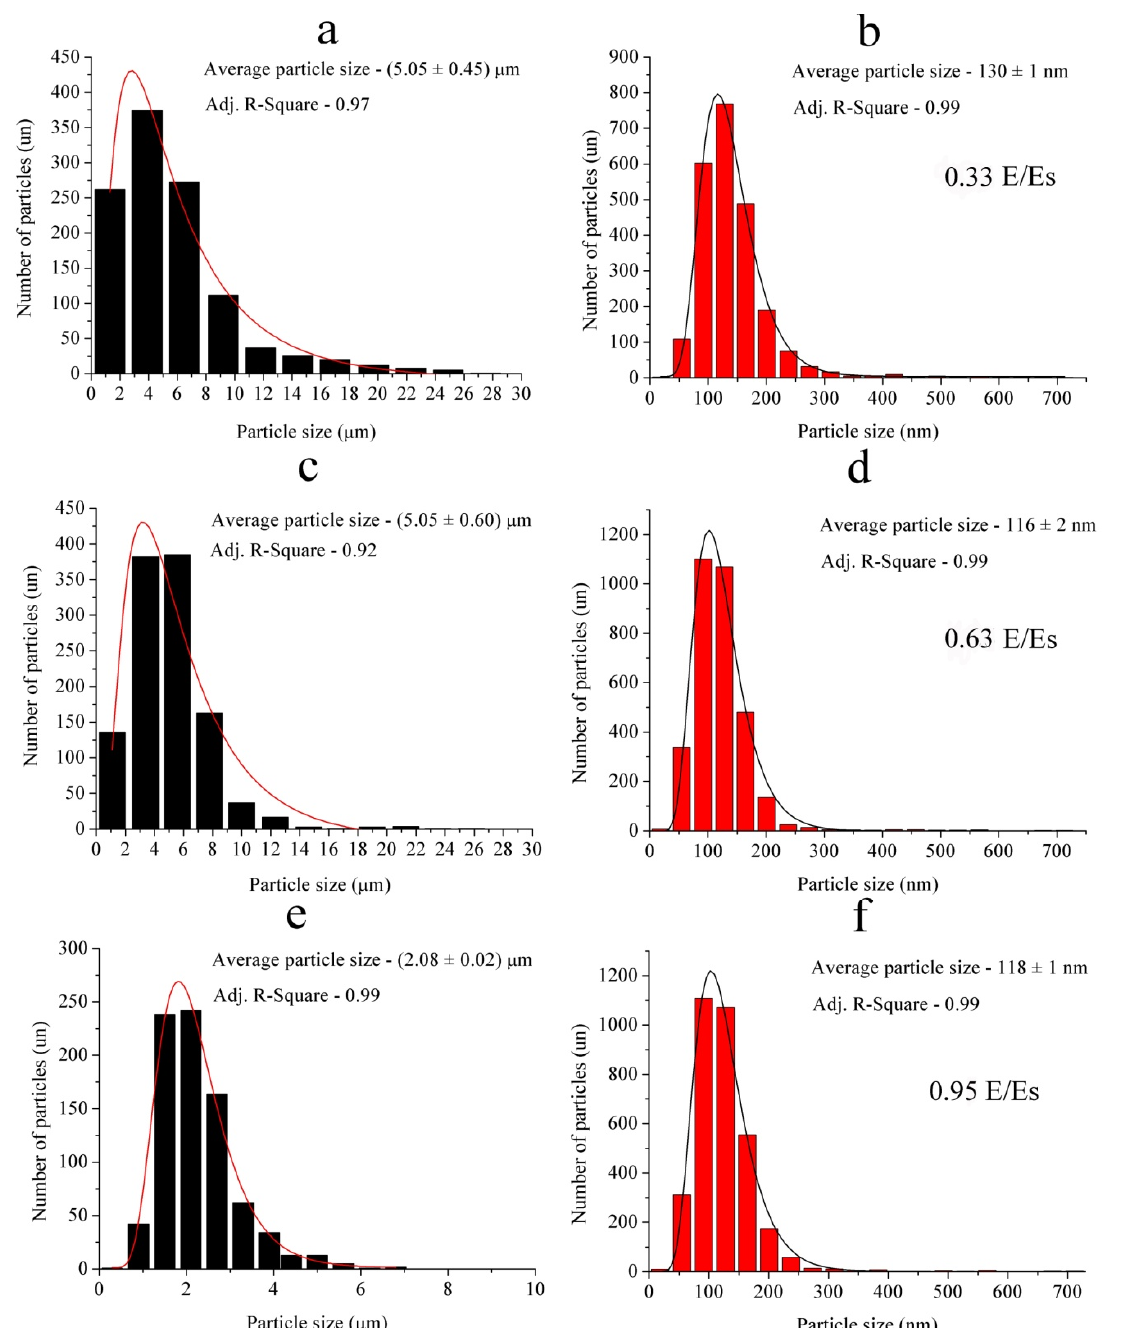
Figure 5. Microparticle ( a , c , e ) size distribution and nanoparticle and submicron particle ( b , d , f ) size distribution: ( a , b ) Sample 1, ( c , d ) Sample 2, ( e , f ) Sample 3.